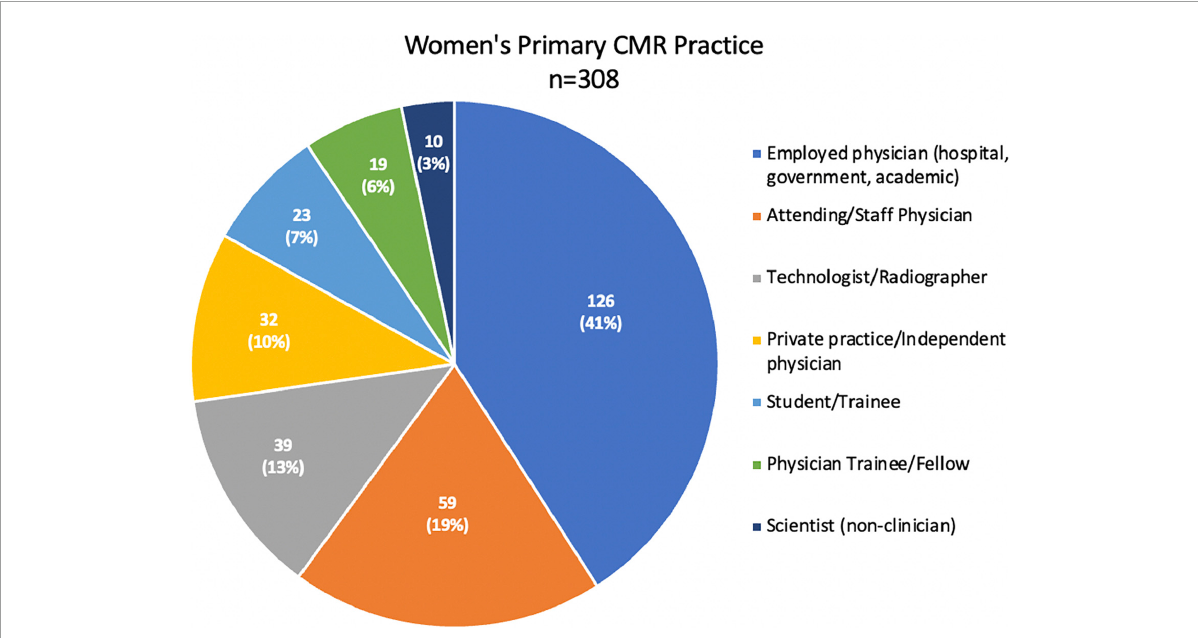
FIGURE5 Women’s primary CMR practice of the CMR survey practitioners. Responses in this category = 308. This pie graph shows the distribution of the women’s primary CRM practice as employed physicians at different kinds of institutions such as academic, community, or government hospitals ( n = 126, 41%), attending or staff physicians ( n = 59, 19%), technologists or radiographers ( n = 39, 13%), private practice or independent physicians (32, 10%), pre-grade students or trainees (23, 7%), physician trainees, residents or fellows (19, 6%), and scientist (non-clinician) (10,